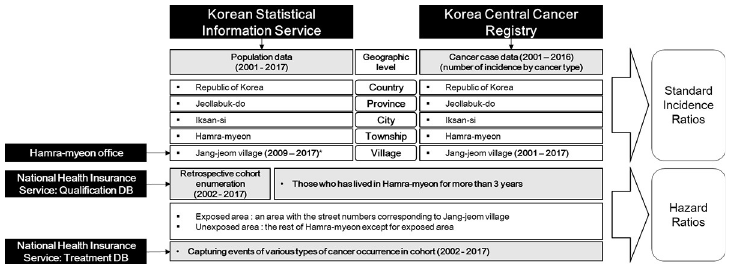
Fig 1. Sources and purpose of data collected for estimating cancer risks. Black boxes indicate the data sources for the study, and light gray boxes indicate collected data or database. Final outcome estimates are standard incidence ratios and hazard ratios for cancer in the Jang-jeom village residents. � With an assumption that the Jang-jeom village’s demographics for 2001–8 are the same as for 2009, standard incidence ratios for 2001–9 can also be calculated.